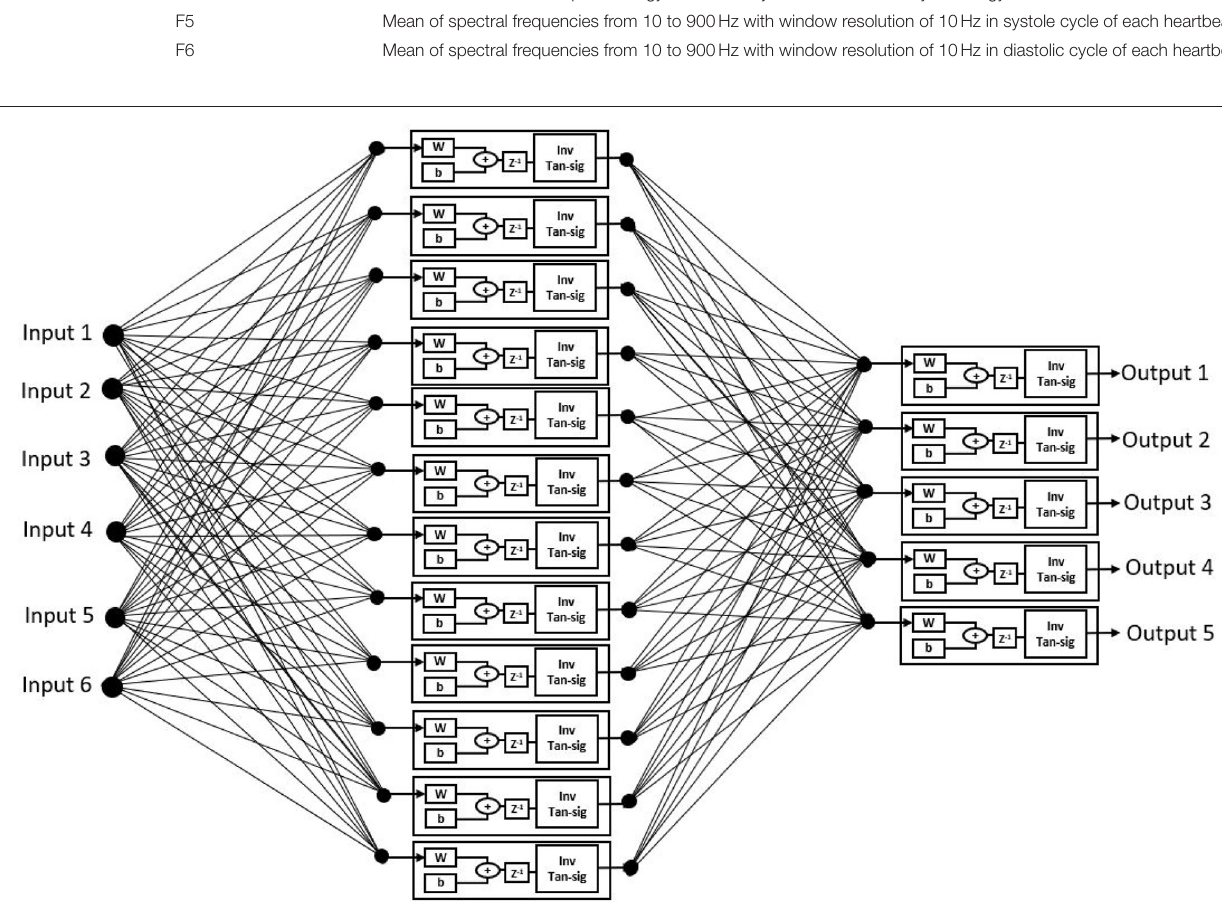
FIGURE 3 | Artificial neural networks (ANNs) using the ID function neuron